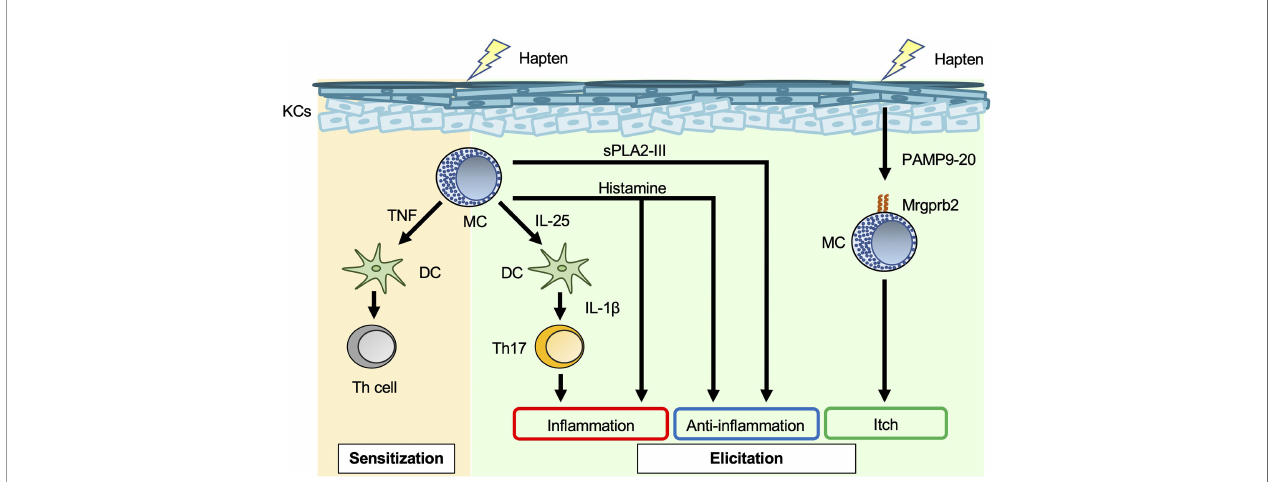
FIGURE 2 | Mast cells in acute contact hypersensitivity. Mast cell (MC)-derived TNF enhances skin dendritic cell (DC) migration to draining LNs, leading to induction of hapten-speci fi c Th-cell expansion in the sensitization phase of contact hypersensitivity (CHS). MC-derived IL-25 induces IL-1 b production by dermal DCs, followed by promotion of IL-17 production by Th17 cells in the elicitation phase of CHS. Histamine has dual roles, i.e., in fl ammatory and anti-in fl ammatory, in the elicitation phase of CHS. Haptens stimulate keratinocytes (KCs) to produce PAMP9-20, a ligand for Mrgprb2. PAMP9-20 induces itch during